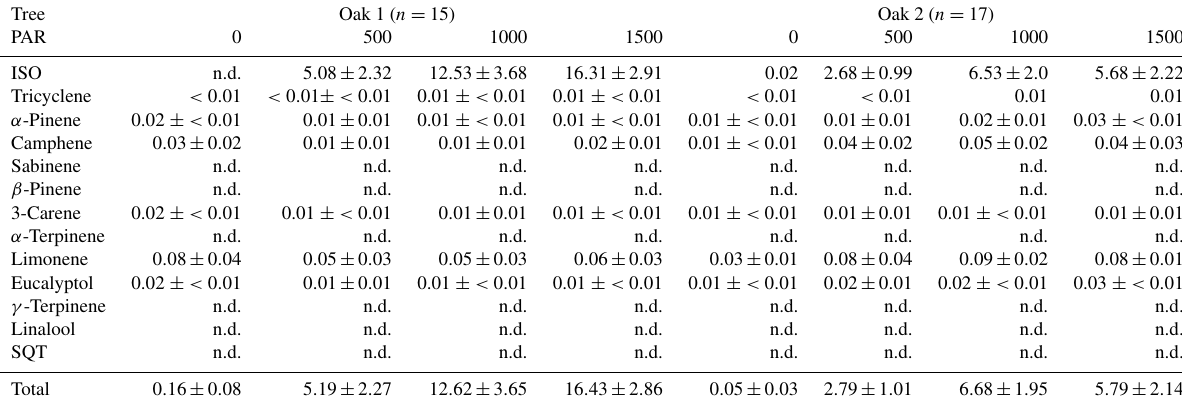
Table A1. The mean average actual emission ( ± SD) of detected compounds at light levels (PAR) 0, 500, 1000 and 1500µmolm − 2 s − 1 and the number of samples taken from English oak ( Quercus robur ) in µggdw 1 h − 1 . No data (n.d.) indicates that the compound was not detected in any sample for the measured light level on that particular